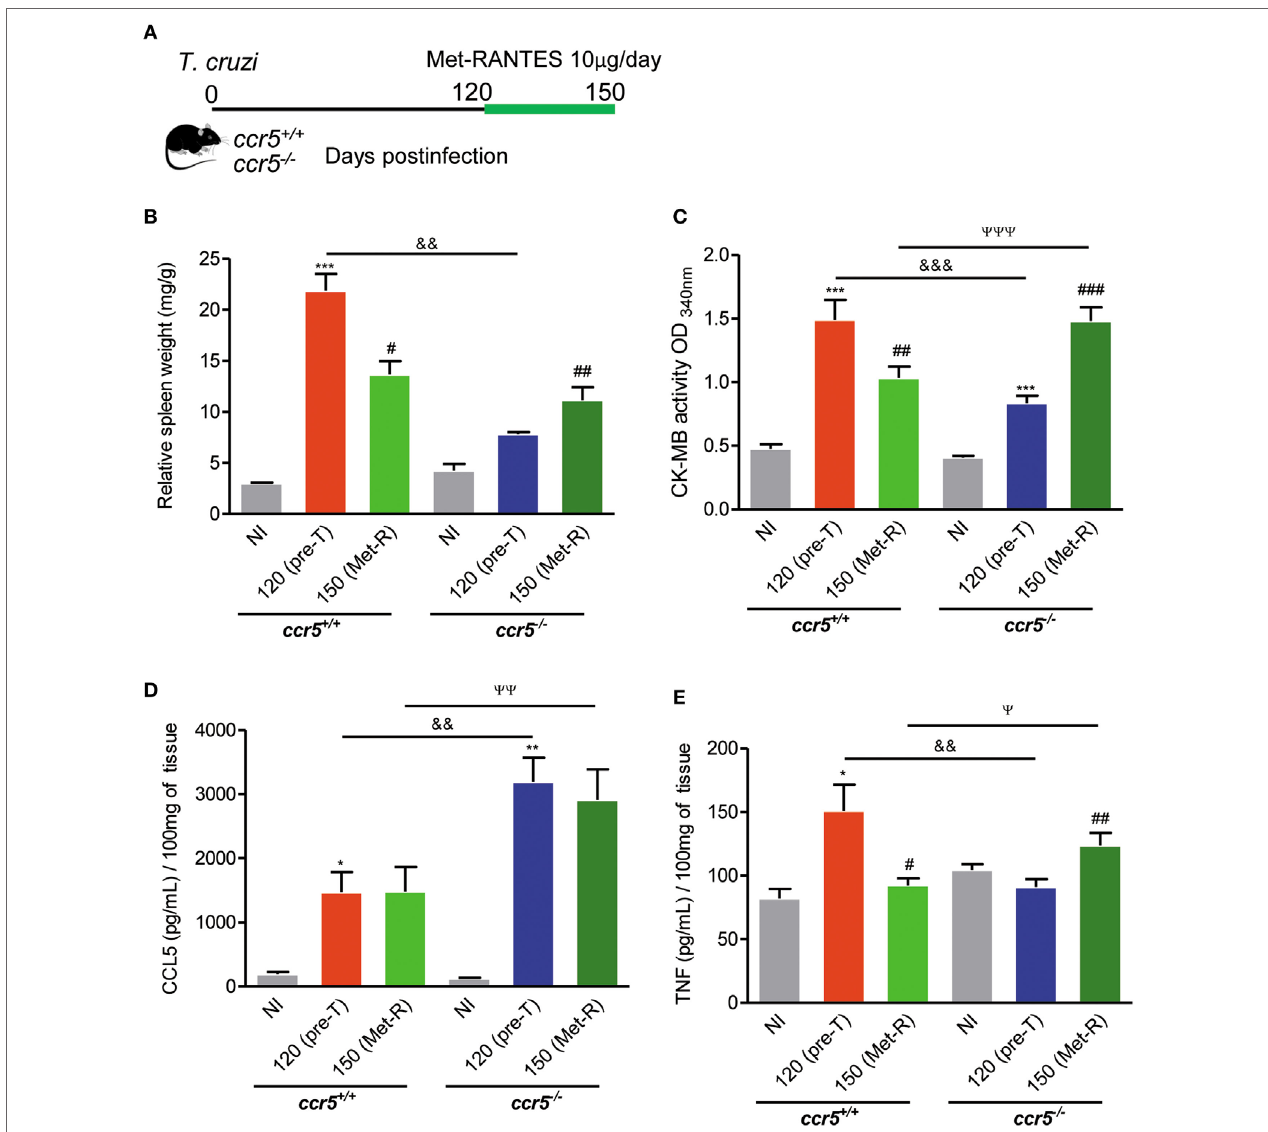
FigUre 4 | Effects of Met-RANTES treatment on splenomegaly, myocardial injury, and CCL5 and TNF concentrations in the heart tissue of T. cruzi -infected mice. (a) Mice were infected with 100 trypomastigote forms of the Colombian T. cruzi strain and treated with Met-RANTES (Met-R, 10 µg/mice) from 120 to 150 days postinfection (dpi). Sera were collected (at 120 and 150 dpi) for estimation of CK-MB activity. Hearts were collected (at 150 dpi) for evaluation of CCL5 and TNF concentrations by enzyme-linked immunosorbent assay (ELISA). (B) The relative weight of the spleen (spleen weight in milligrams/body weight in grams) at 150 dpi. (c) CK-MB activity in serum determined by biochemical assay at 120 (pretherapy) and 150 dpi (posttherapy, Met-R). (D) CCL5 concentrations in extracts of heart tissue evaluated by ELISA at 150 dpi. (e) TNF concentrations in extracts of heart tissue evaluated by ELISA at 150 dpi. Data represent two independent experiments with 3–5 noninfected (NI) and 7–10 infected mice.* P < 0.05, ** P < 0.01, *** P < 0.001, T. cruzi -infected mice vs NI; # P < 0.05, ## P < 0.01, and ### P < 0.001, pretreated vs Met-R-treated; && P < 0.01, &&& P < 0.001, Ccr5 − / − vs Ccr5 + / + T. cruzi -infected mice pretreatment (120 dpi); ψ P < 0.05, ψψ P <